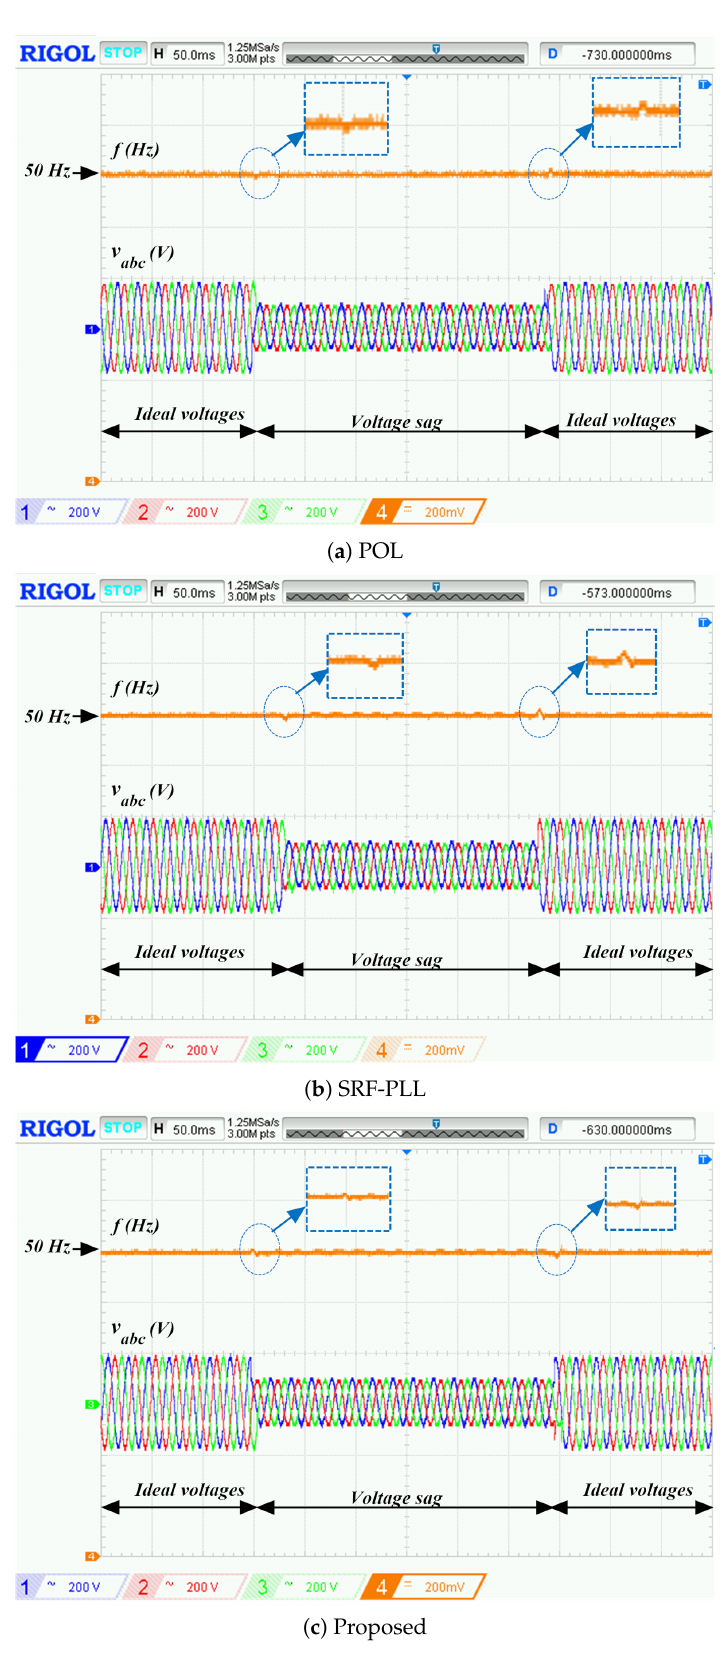
Figure 11. Comparative experimental results for a − 0.5 p.u. voltage step